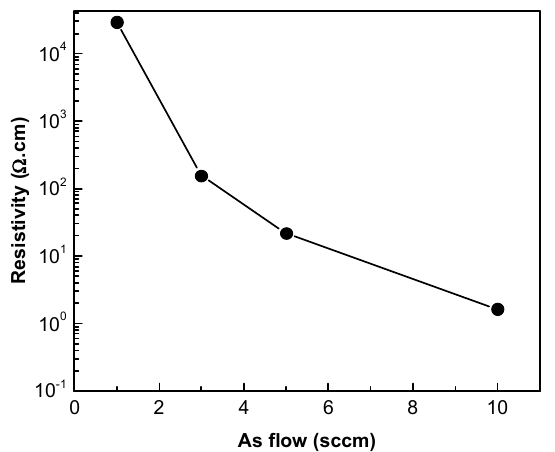
Figure 2. Resistivity change in As-doped px ZnTe reference thin films with As precursor flows.